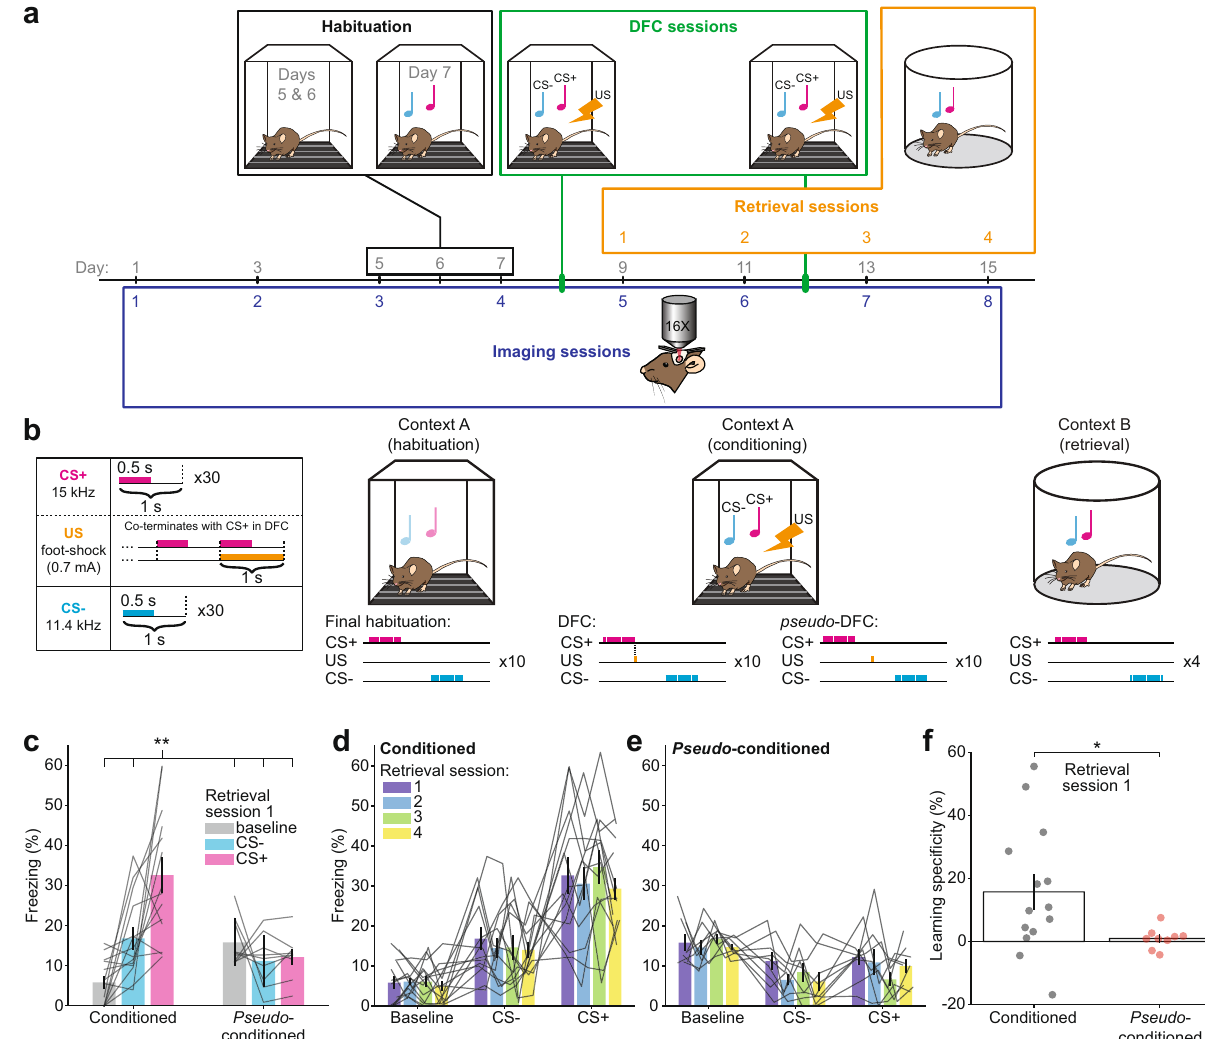
Fig. 1 Experimental timeline and differential fear conditioning (DFC) paradigm. a Experimental timeline: Mice were imaged for 4 sessions (48 h apart) before DFC to establish baseline responses to tone pip stimuli under the two-photon. Prior to DFC, mice were habituated to the fear conditioning chamber. Mice were subjected to DFC (19 mice) or pseudo -conditioning (9 mice) on Days 8 and 12. After DFC-1 (day 8), fear retrieval testing was performed